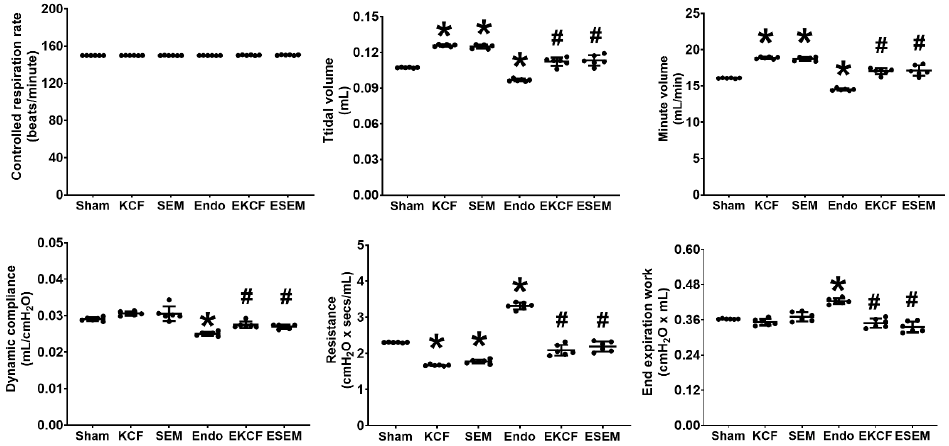
Figure 3. Lung function status. Lung function parameters, including controlled respiration rate, tidal volume, minute volume, dynamic compliance, resistance, and end expiration work were measured at 24 h after endotoxin or normal saline administration. Sham: the normal saline group. KCF: the normal saline plus the KCF18 peptide group. SEM: the normal saline plus the SEM18 peptide group. Endo: the endotoxin group. EKCF: the endotoxin plus the KCF18 peptide group. ESEM: the endotoxin plus the SEM18 peptide group. Data were obtained from six mice in each group and presented as the mean ± standard deviation. * p < 0.05, versus the Sham group. # p < 0.05, versus the Endo group.